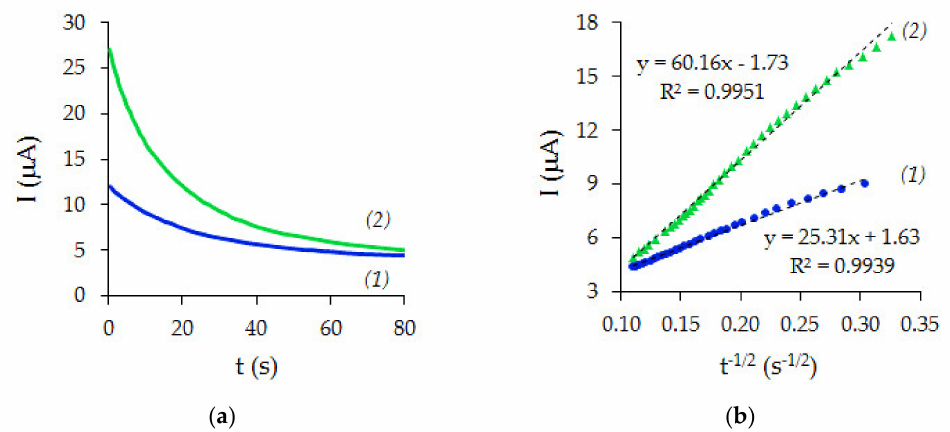
Figure 7. Chronoamperograms obtained at 0.9 V potential on the FCVE ( 1 ) and the TrX100 / FCVE ( 2 ) in 0.1 M KCl containing 1.0 mM K 4 [Fe(CN) 6 ] ( a ). Dependencies I = f (t − 1 / 2 ) are obtained from chronoamperograms on the corresponding electrodes ( b